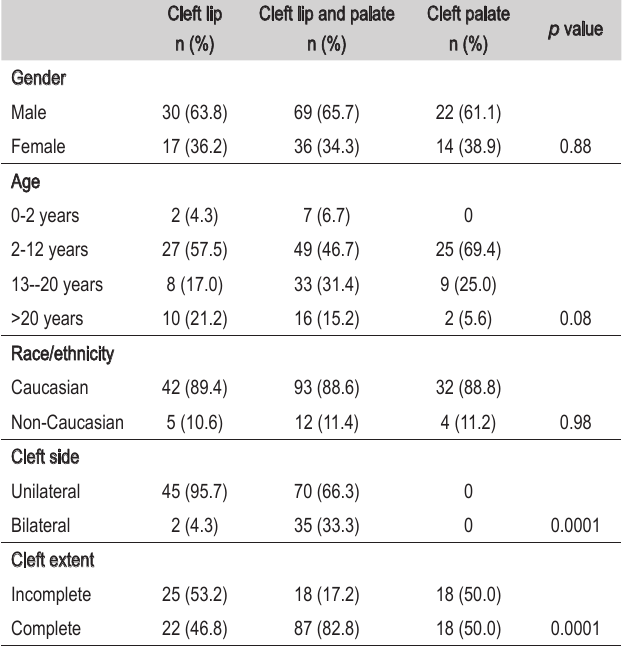
Table 1 - Distribution by gender and race and clinical extent of the clefts.